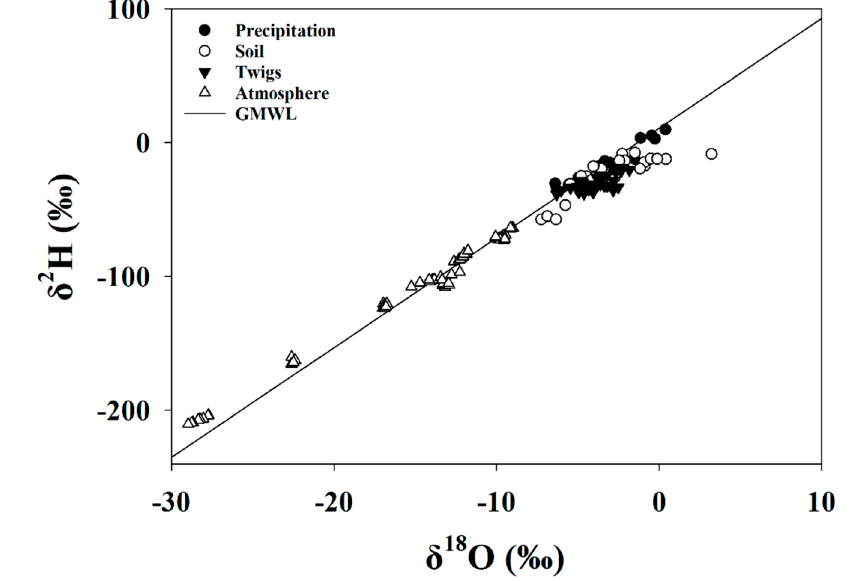
Figure 6. δ 2 H versus δ 18 O for soil, precipitation, twig, and atmospheric water samples as related to the global meteoric water line (GMWL) for the entire study period.